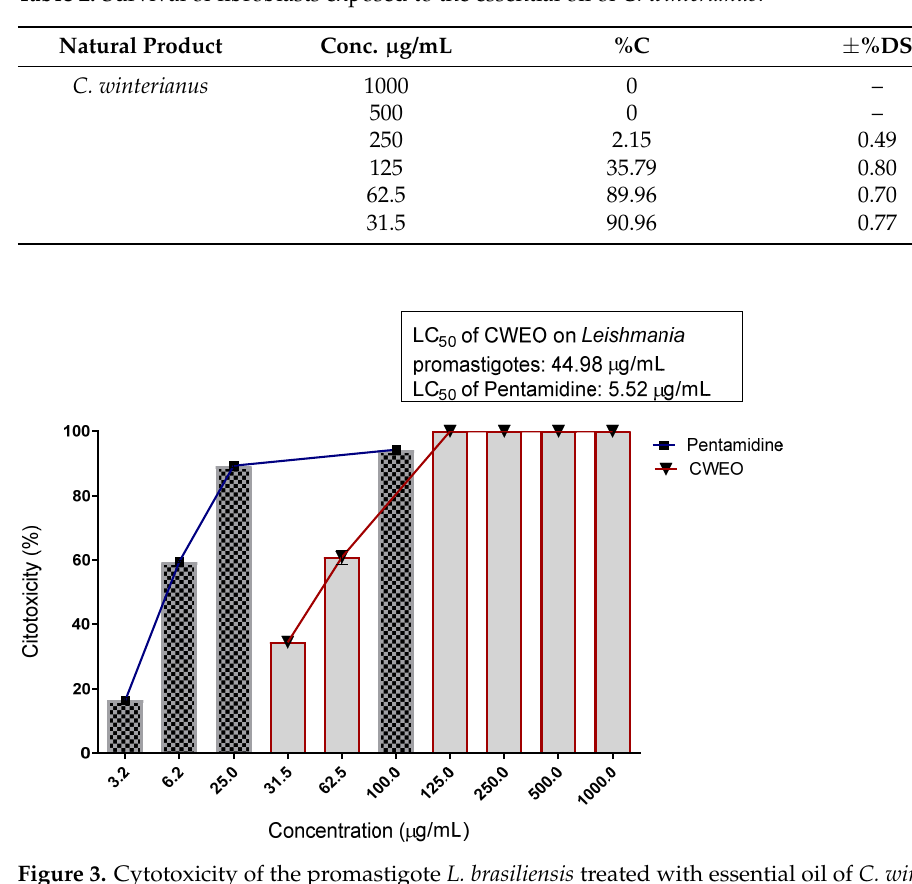
Figure 3. Cytotoxicity of the promastigote L. brasiliensis treated with essential oil of C. winterianus. LC 50 , with the confidence interval for oil at 95% (35.55–56.92). LC 50 was obtained through non-linear regression of